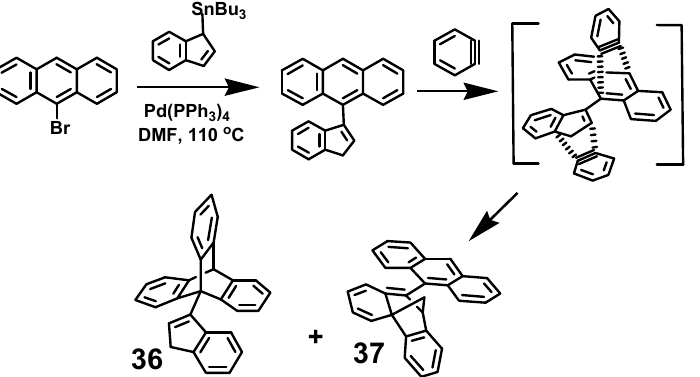
Scheme 15. Palladium-catalysed route to 3-(9-indenyl)anthracene and its benzyne adducts 36 and 37 .